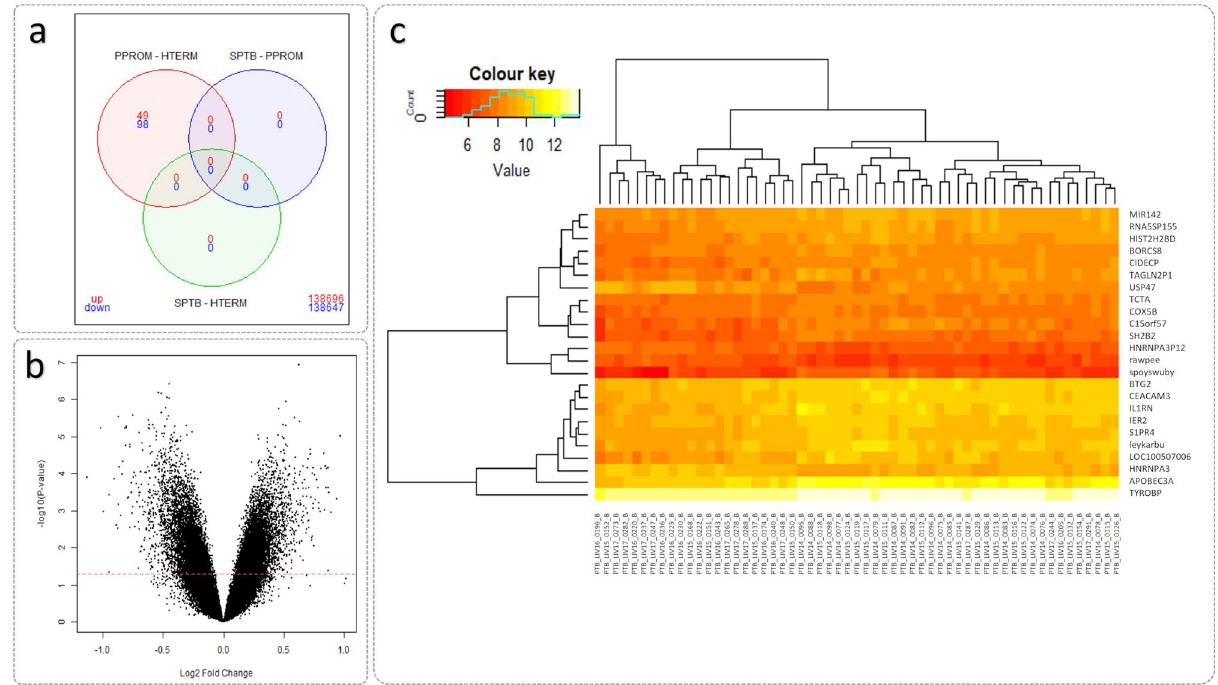
Figure 5. Significant DEGs identified from PPROM versus HTERM analysis at week 20 gestation of 57 maternal samples. ( a ) Venn diagram of 147 DEGs (49 upregulated and 98 downregulated) were significant at FDR p < 0.05. ( b ) Volcano plot of DEGs based on nominal p < 0.05. ( c ) Heatmap outlining 24 DEGs (with annotations available) that reached FDR p < 0.03. These figures were produced suing ‘limma’ R package 30 .